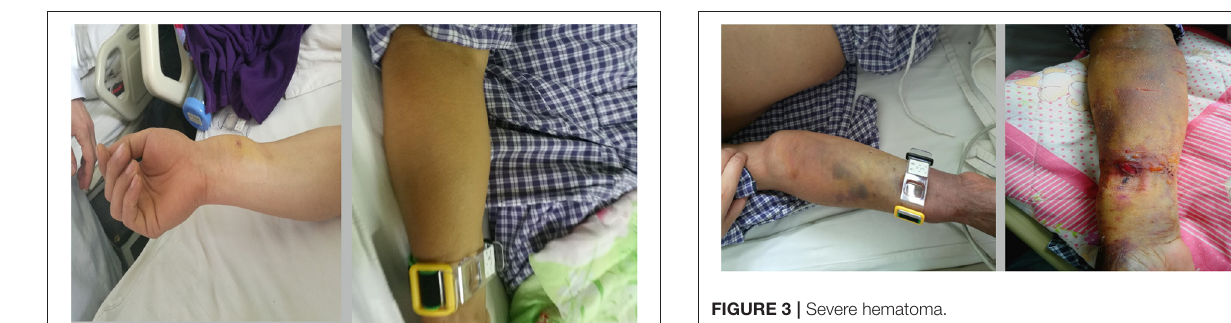
FIGURE 1 | Mild hematoma.